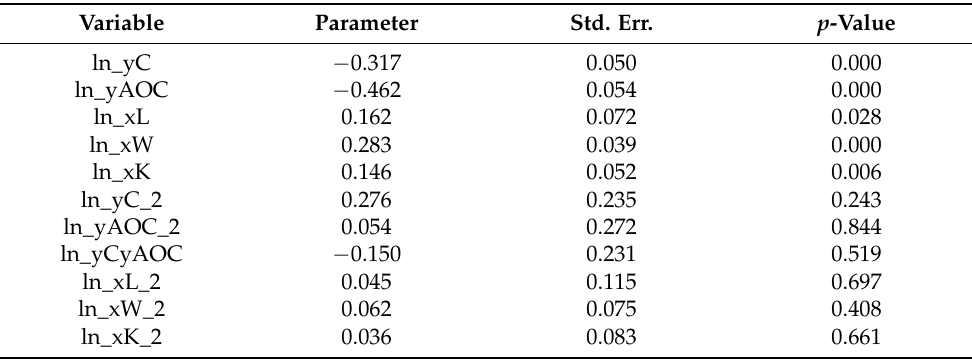
Table A1. IDF—agriculture. Source: authors’